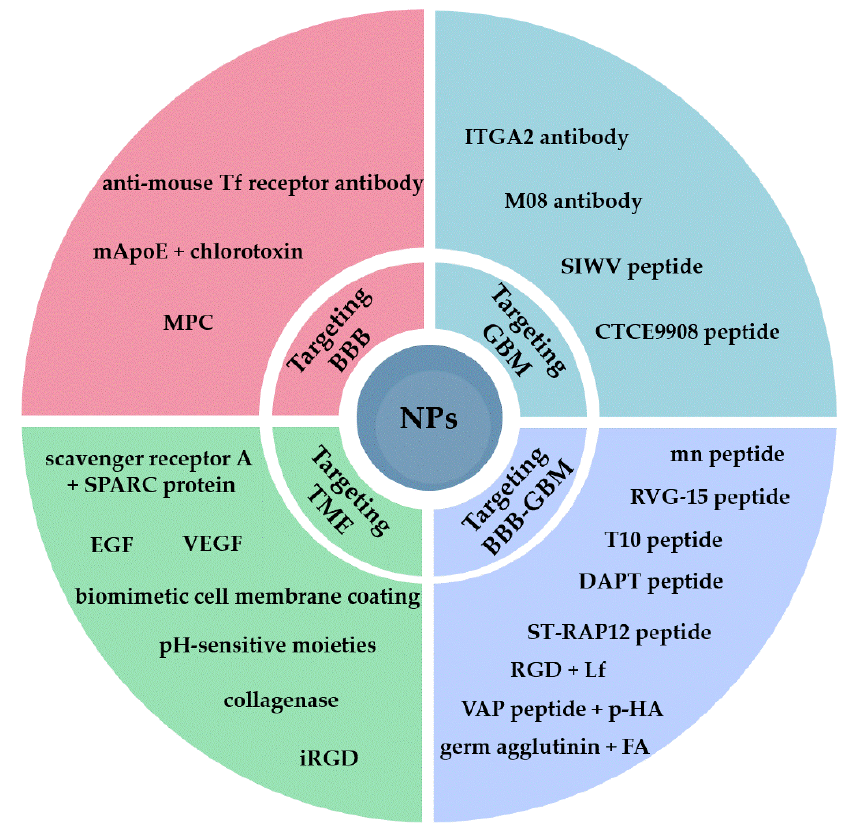
Figure 1. Schematic representation of novel molecules investigated as targeting moieties for the development of targeted NPs, as well as those targeting the TME for GBM therapy. Abbreviations: BBB—blood-brain barrier; EGF—epidermal growth factor; FA—folic acid;